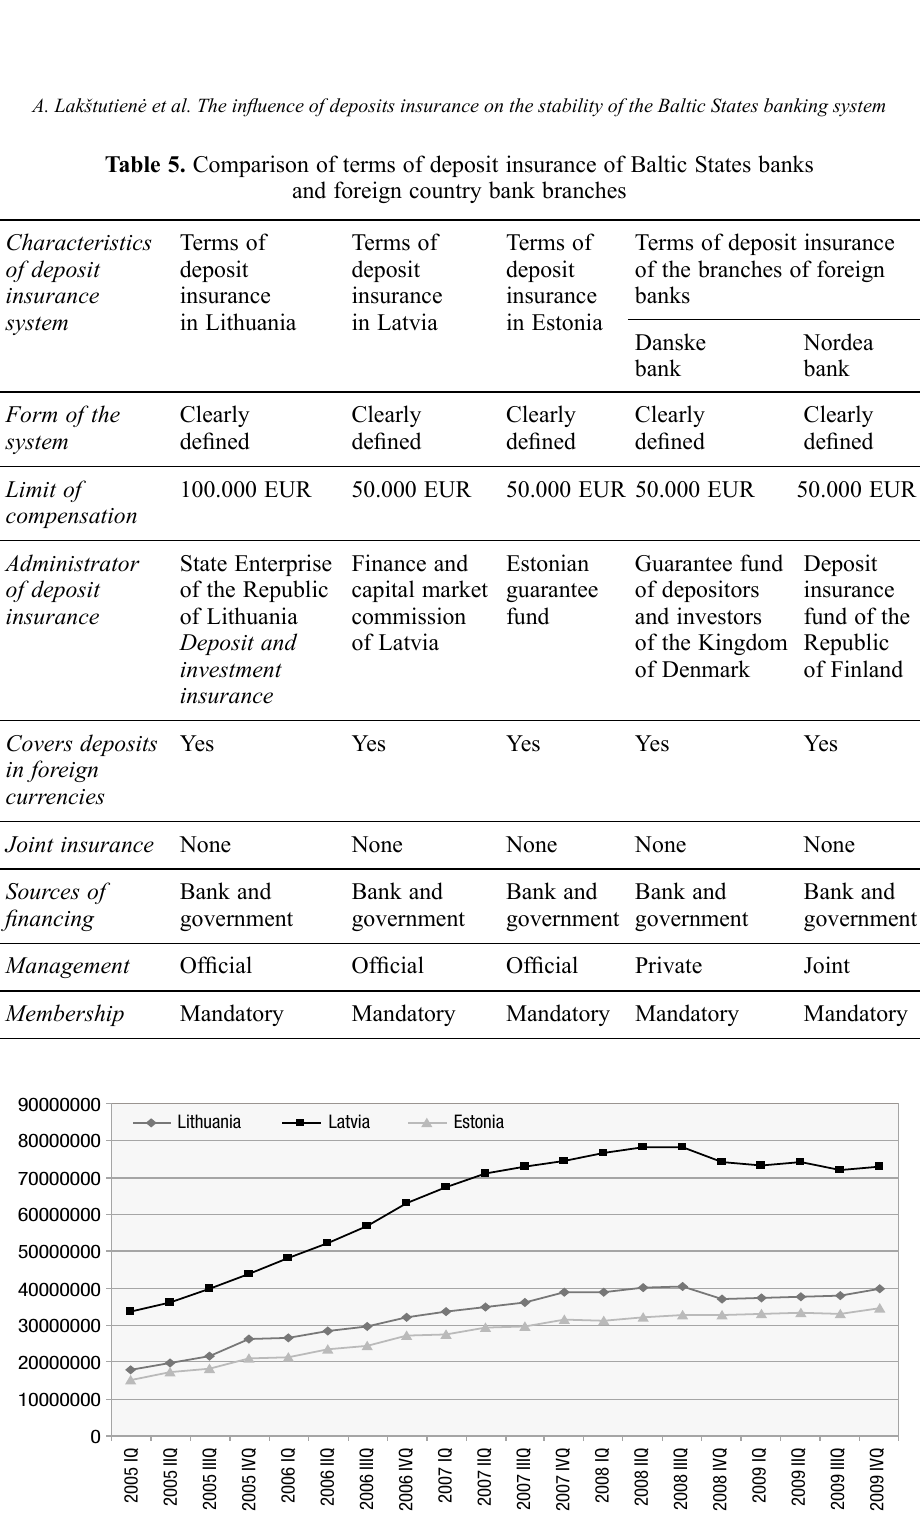
Fig. 4. Size of deposits in million LTL in the Baltic States from 2005 to